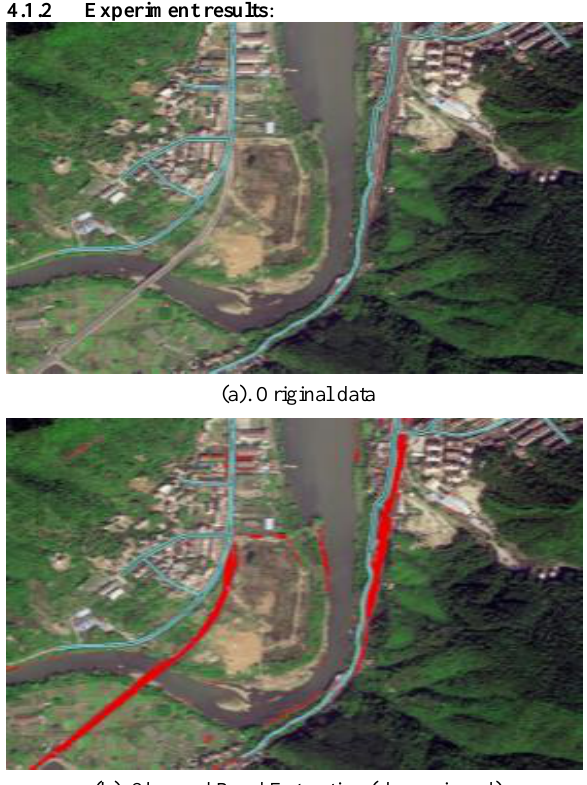
Figure 5. Changed Road Extraction